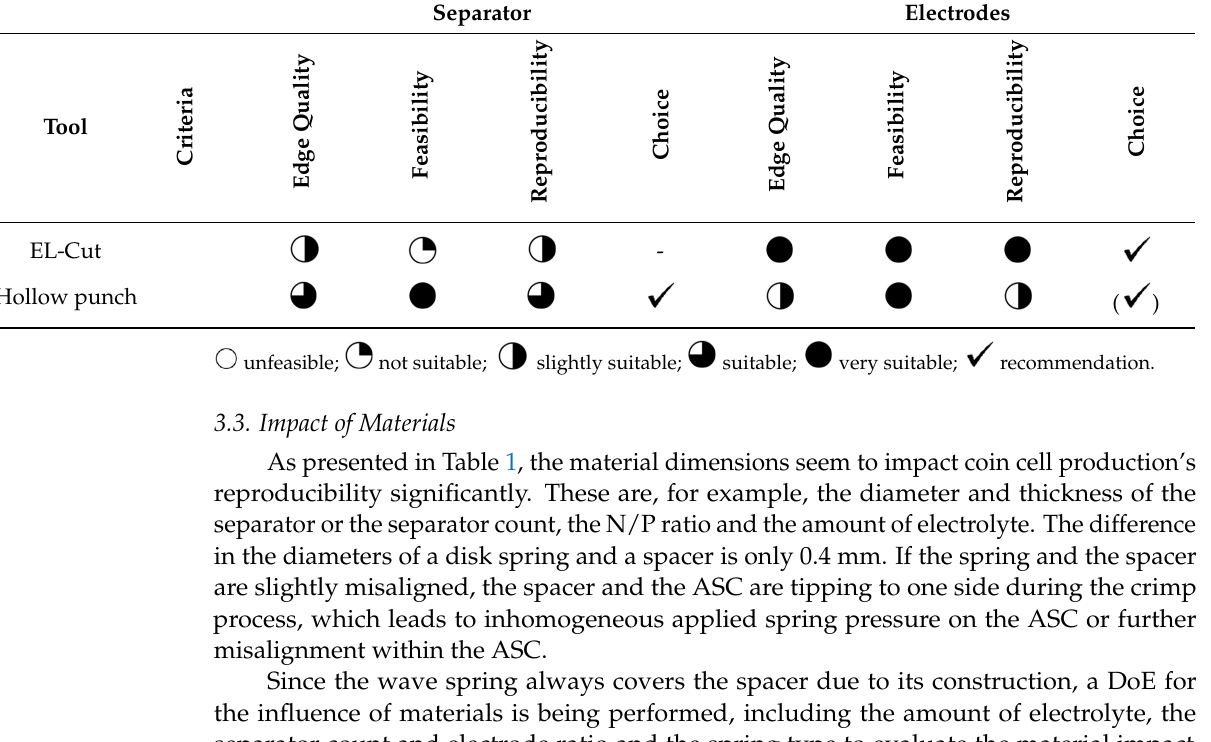
Table 4. Tool suitability for punching separators and electrodes.